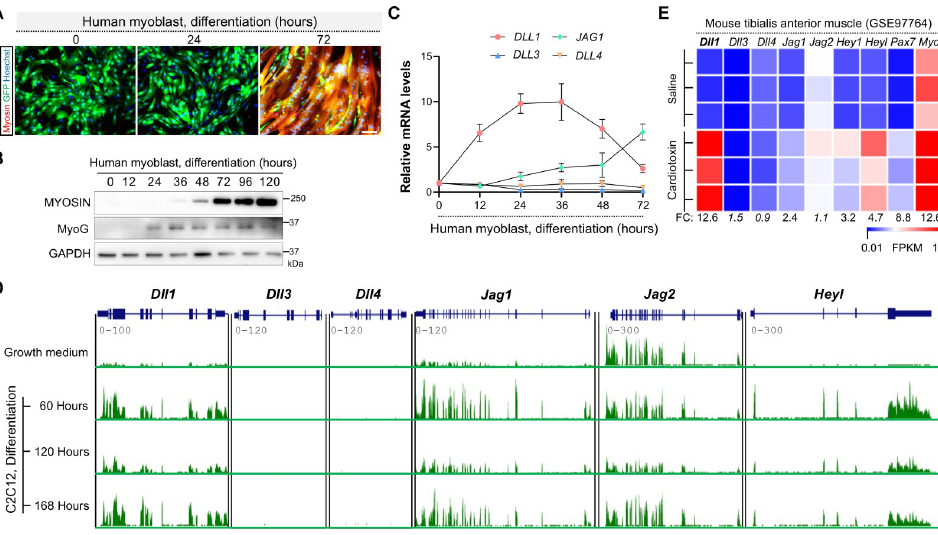
Fig 1. Robust inductions of Dll1 expression by myogenic cues in both mouse and human cells. ( A ) Human myoblasts display high myogenic and fusogenic potentials in culture. Cells were labelled by GFP to visualize the syncytium at early stages of differentiation. Scale bar, 100 μ m. ( B ) Western blotting results of myosin (MF20 antibody) and Myogenin (MyoG) in human myoblasts at various stages of differentiation. ( C ) qPCR results of Notch ligand genes during human myoblast differentiation. The Ct values for each gene at growth-culture condition (time 0) are Dll1 (25.6), Dll3 (26.8), Dll4 (32.4) and Jag1 (28.6). Jag2 expression was not detected. ( D , E ) RNA sequencing results of Notch ligand genes and Notch target Heyl during mouse myoblast differentiation (D, GSE20846) and muscle regeneration (E, GSE97764). CTX (cardiotoxin) samples were from day 3 post injury. FC, expression fold